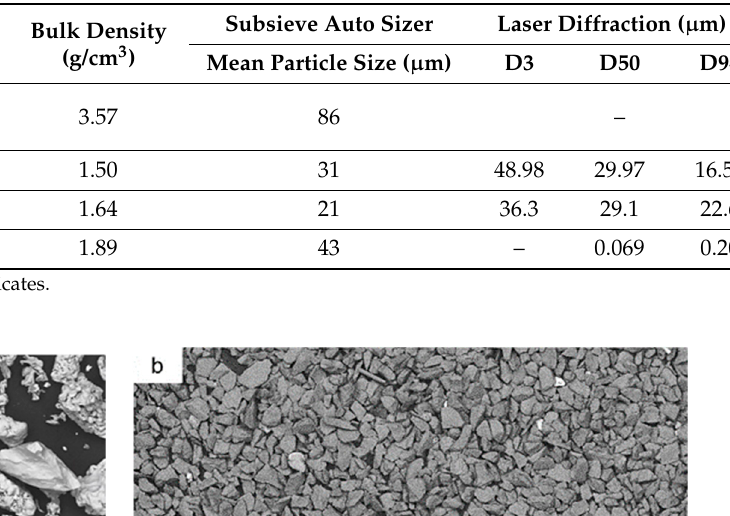
Table 1. Powder properties.